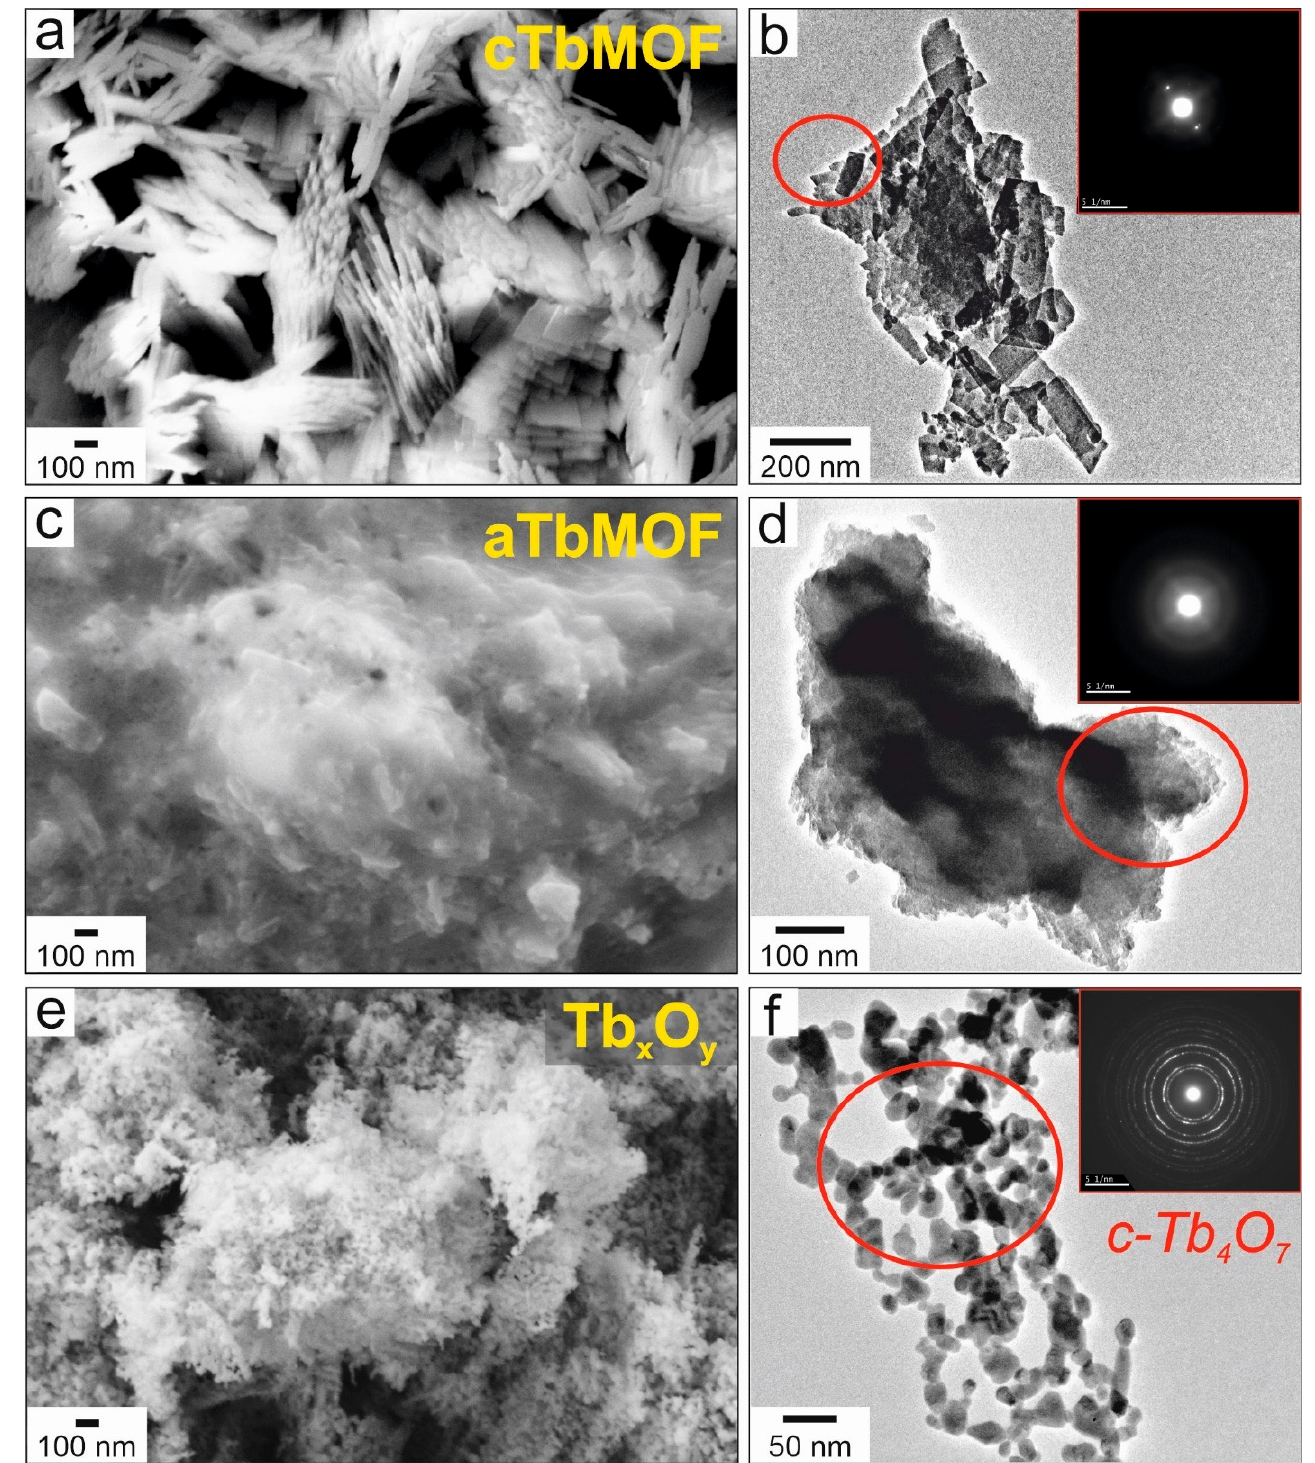
Figure 4. SEM and TEM images of ( a , b ) crystalline (cTbMOF), ( c , d ) amorphous (aTbMOF), and ( e , f ) Tb x O y powders; (insets show their diffractograms).